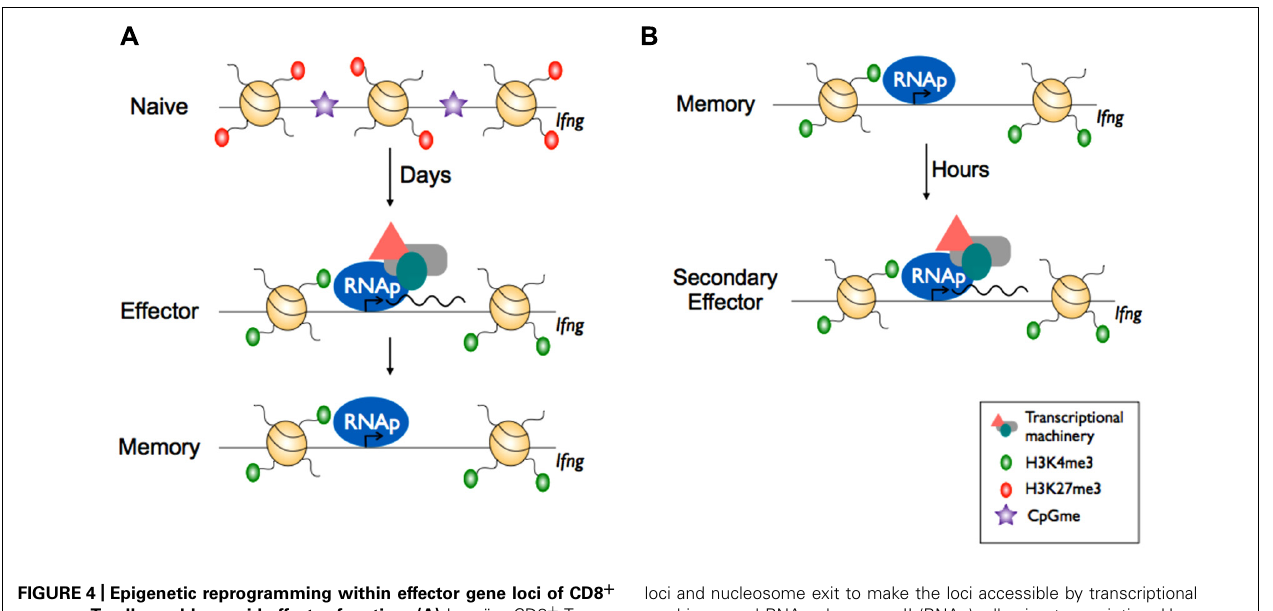
FIGURE 4 | Epigenetic reprogramming within effector gene loci of CD8 + memoryT cells enables rapid effector function . (A) In naïve CD8 + T cells, effector loci such as Ifng display repressive epigenetic marks e.g., H3K27me3 and is inaccessible to transcriptional machinery due to the heterochromatin structure. Upon activation, the chromatin is remodelled whereby it acquires active epigenetic marks e.g., H3K4me3 at key effector